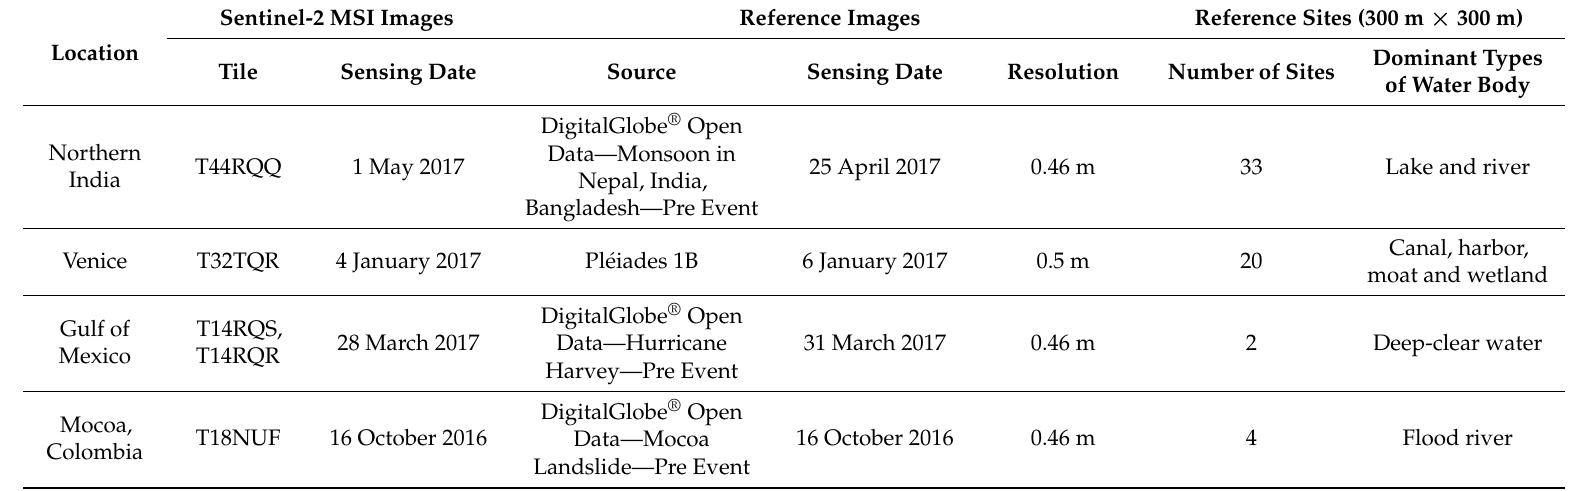
Table 1. Descriptions of Sentinel-2 and reference